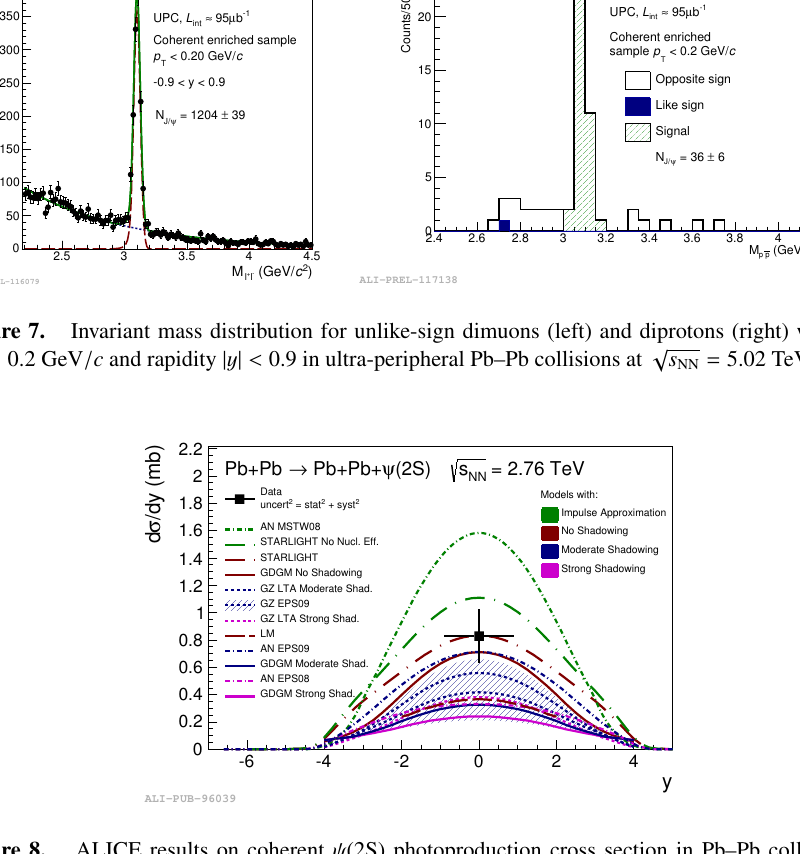
Figure 8. ALICE results on coherent ψ (2S) photoproduction cross section in Pb–Pb collisions at √ s NN = 2 . 76 TeV in comparison with model predictions [15]